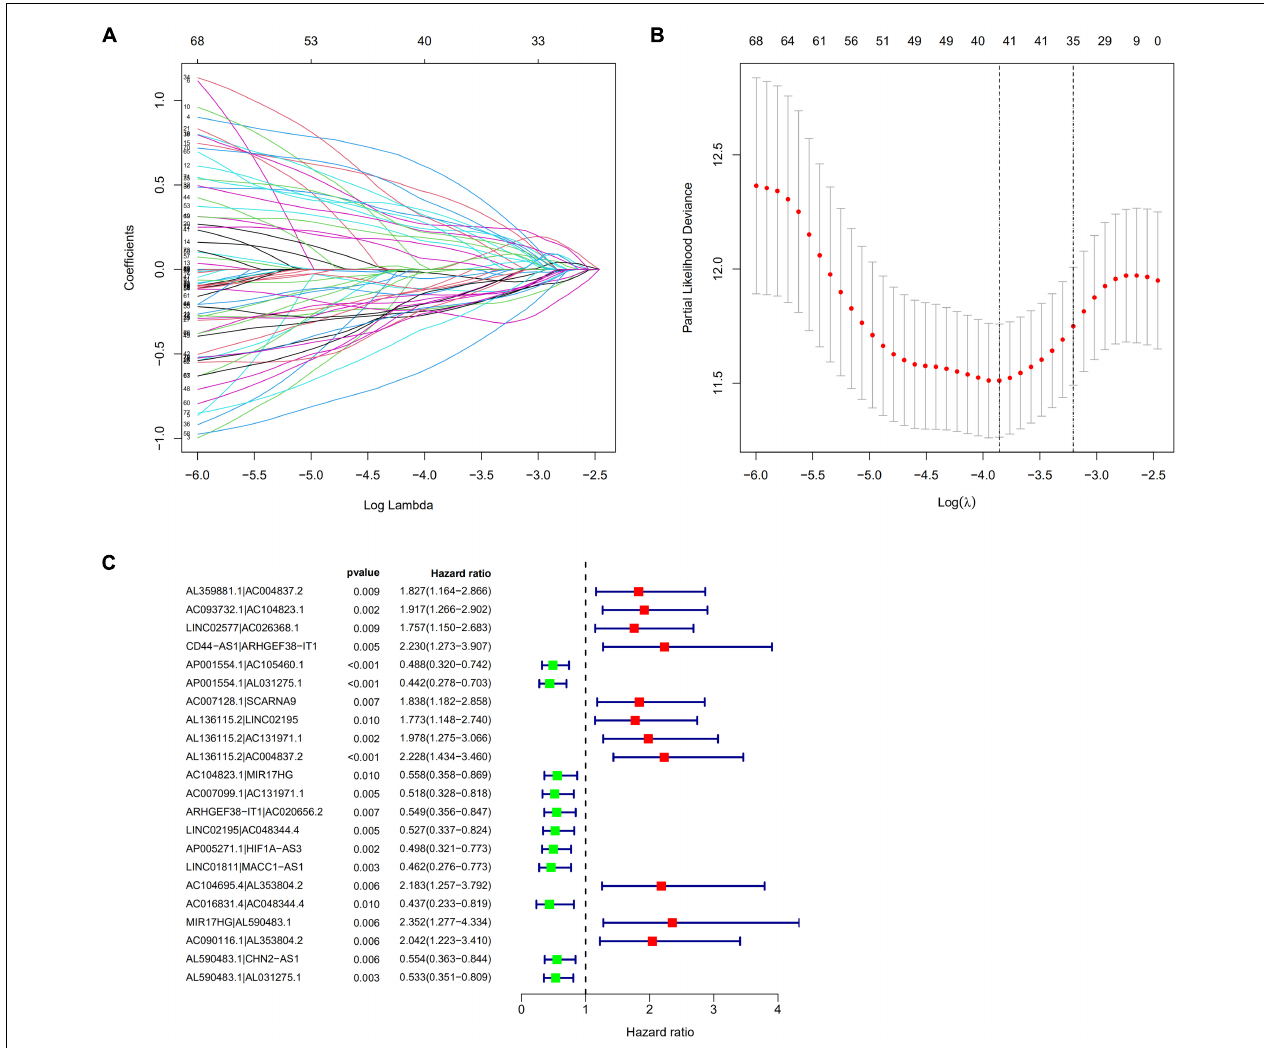
FIGURE 3 | (A,B) 22 lncRNA pairs were screened out using Lasso regression analysis. (C) A forest map showed 22 DEirlncRNA pairs identified by Cox proportional hazard regression in the stepwise method.